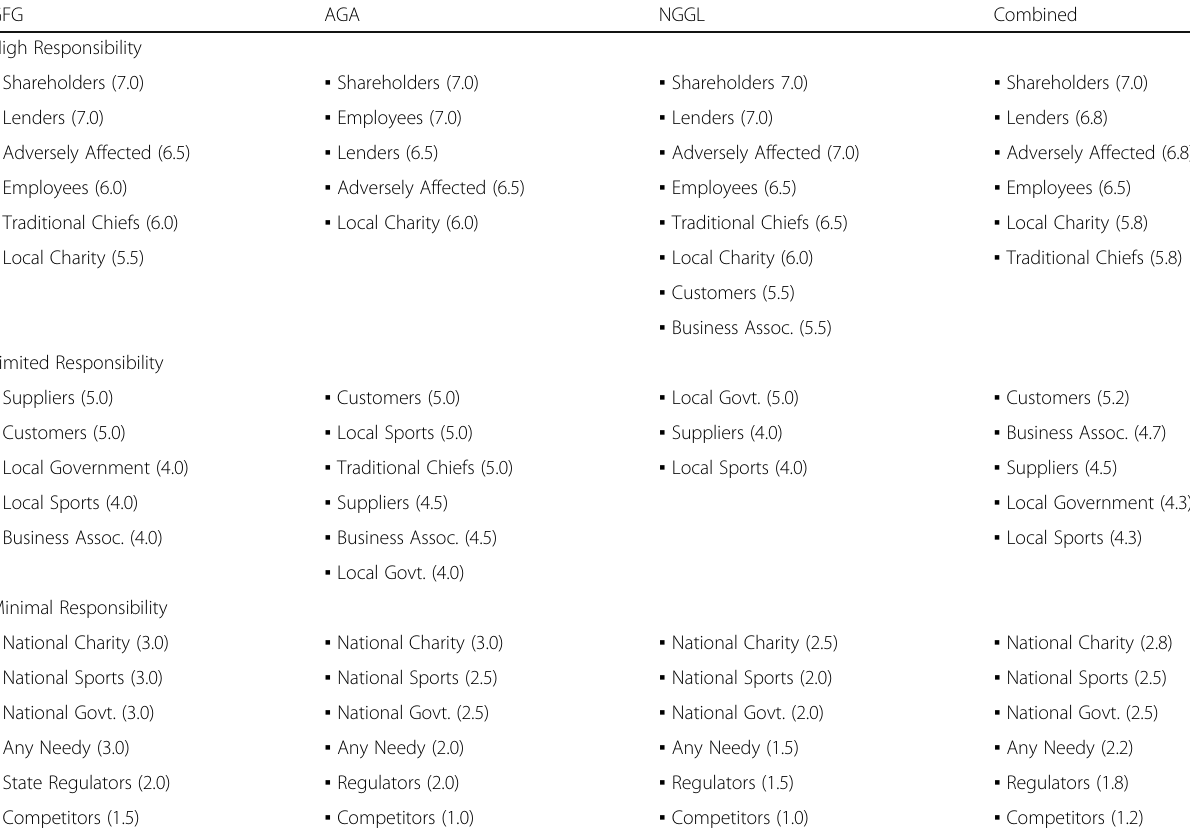
Table 5 Rankings of moral responsibility towards company stakeholders GFG AGA NGGL Combined High